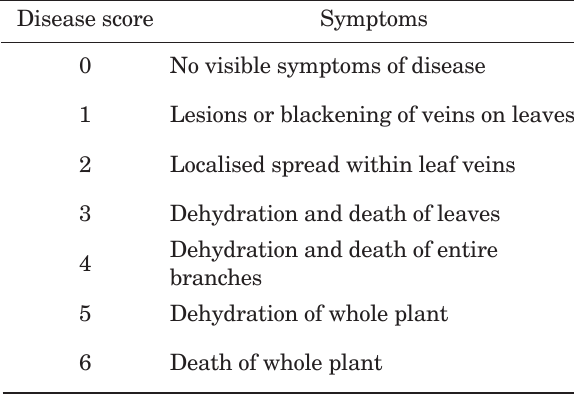
Table 1. Disease scoring system used to assess the progress of coriander